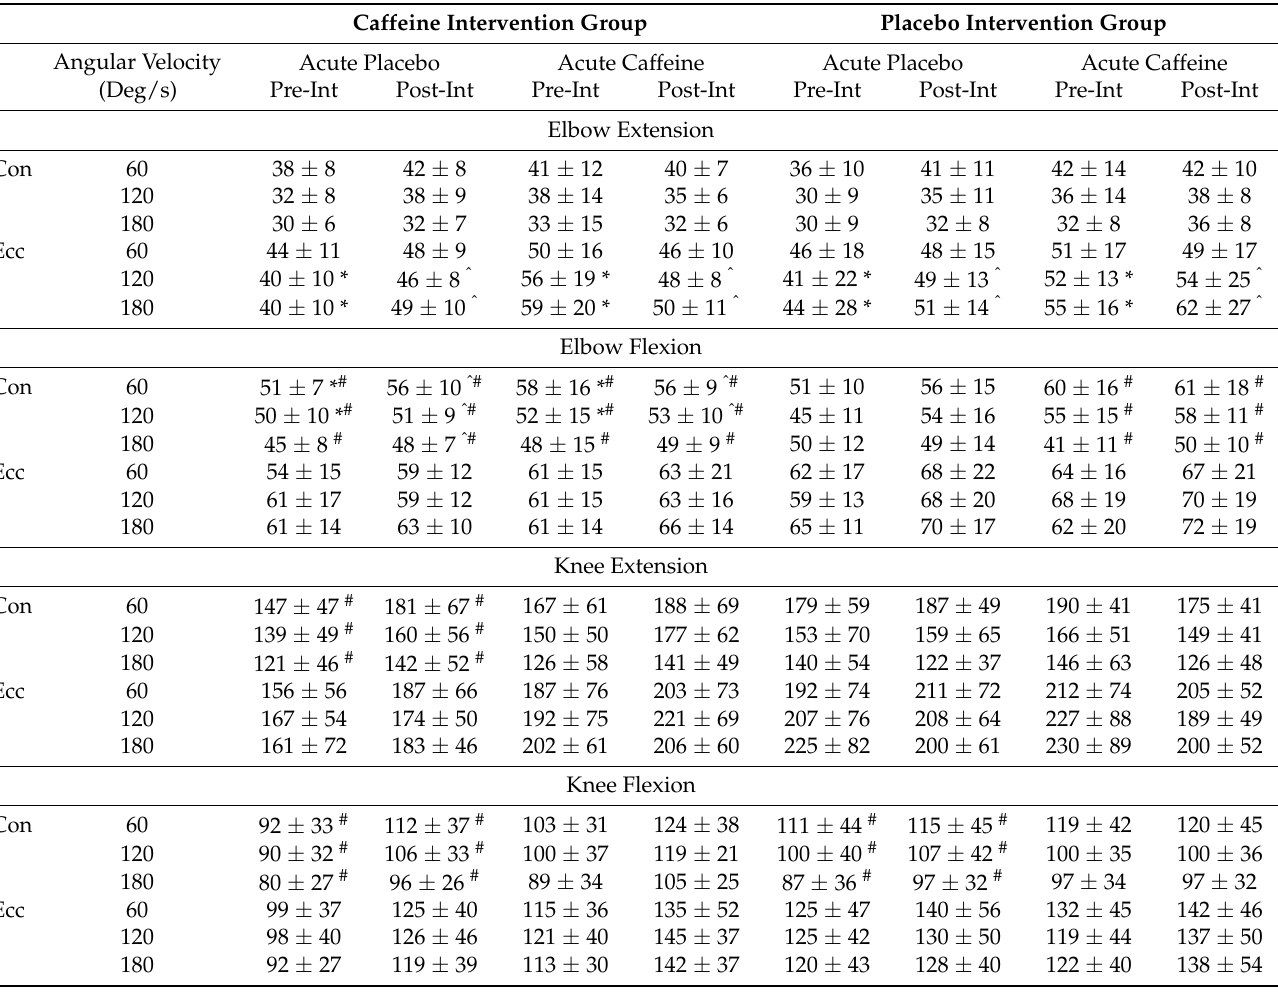
Table 2. Acute effect of caffeine treatment (3 mg · kg − 1 ) pre and post-7-week of resistance training on concentric and eccentric PT (Nm) of the elbow and knee flexors and